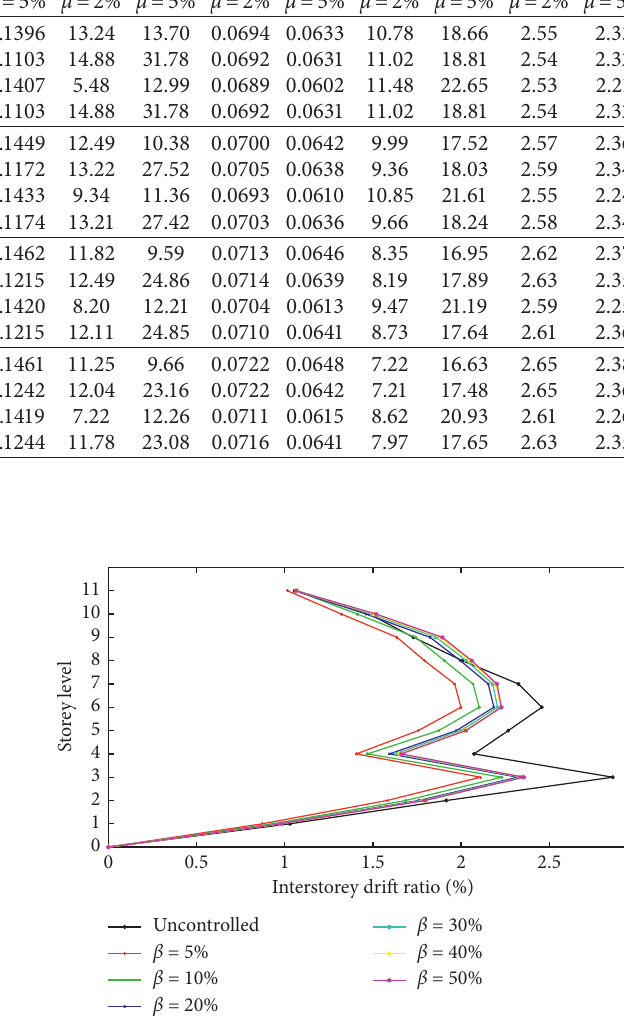
Figure 7: 11 th storey controlled response of the structure subjected to “ El Centro ” acceleration record for TMDI designed with µ � 5% and the J P optimization alternative.